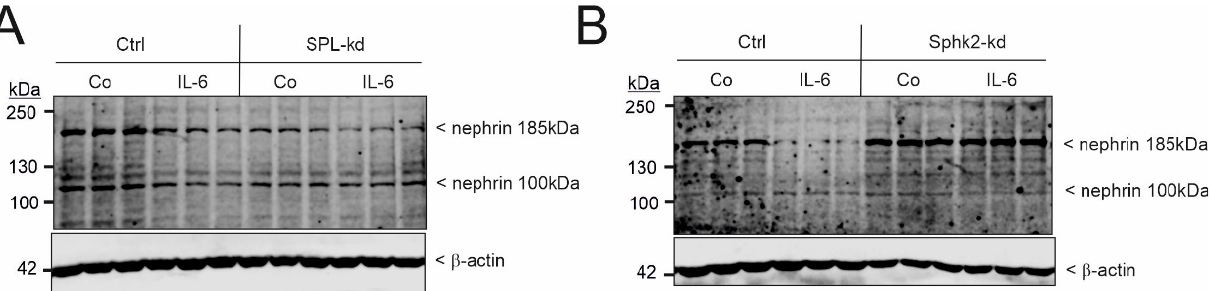
Figure 5. The effect of IL-6 on nephrin expression in SPL-kd and Sphk2-kd podocytes. ( A ) Podocytes that were either transduced with a control vector (Ctrl, A,B), SPL-kd ( A ), or Sphk2-kd ( B ) were treated for 24 h with either the vehicle (Co) or IL-6 (20 ng/mL). Protein extracts were taken for protein separation by SDS-PAGE, transferred to nitrocellulose, and subjected to Western blot analysis using antibodies against nephrin (upper panels) and β -actin (lower panels). Data show representative blots in triplicates. The corresponding bands were evaluated using ImageJ software and are depicted in Supplementary Figure S5.